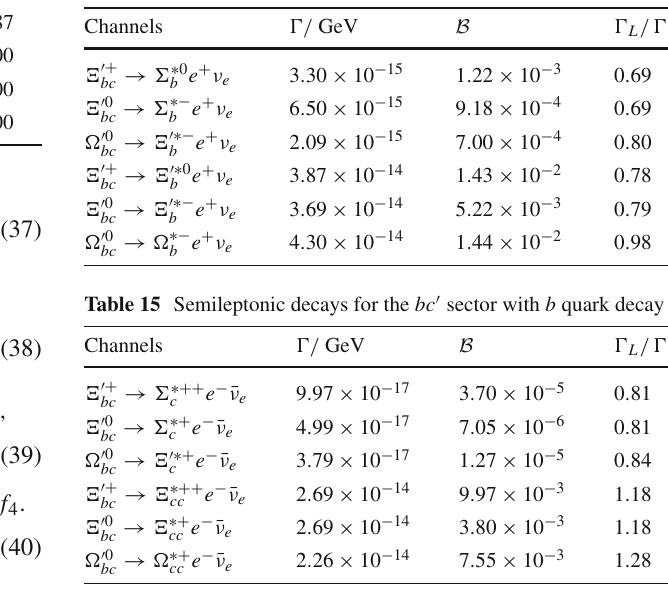
Table 14 Semileptonic decays for the bc (cid:3) sector with c quark decay